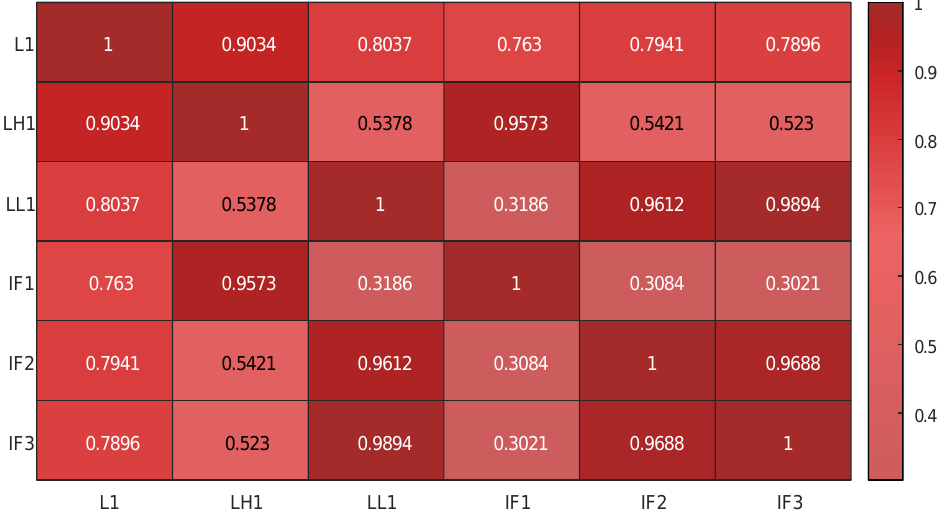
Figure 4. Heat map of solar radiation cross-correlation analysis. Combined with Table 2, the autocorrelation and cross-correlation are used to screen